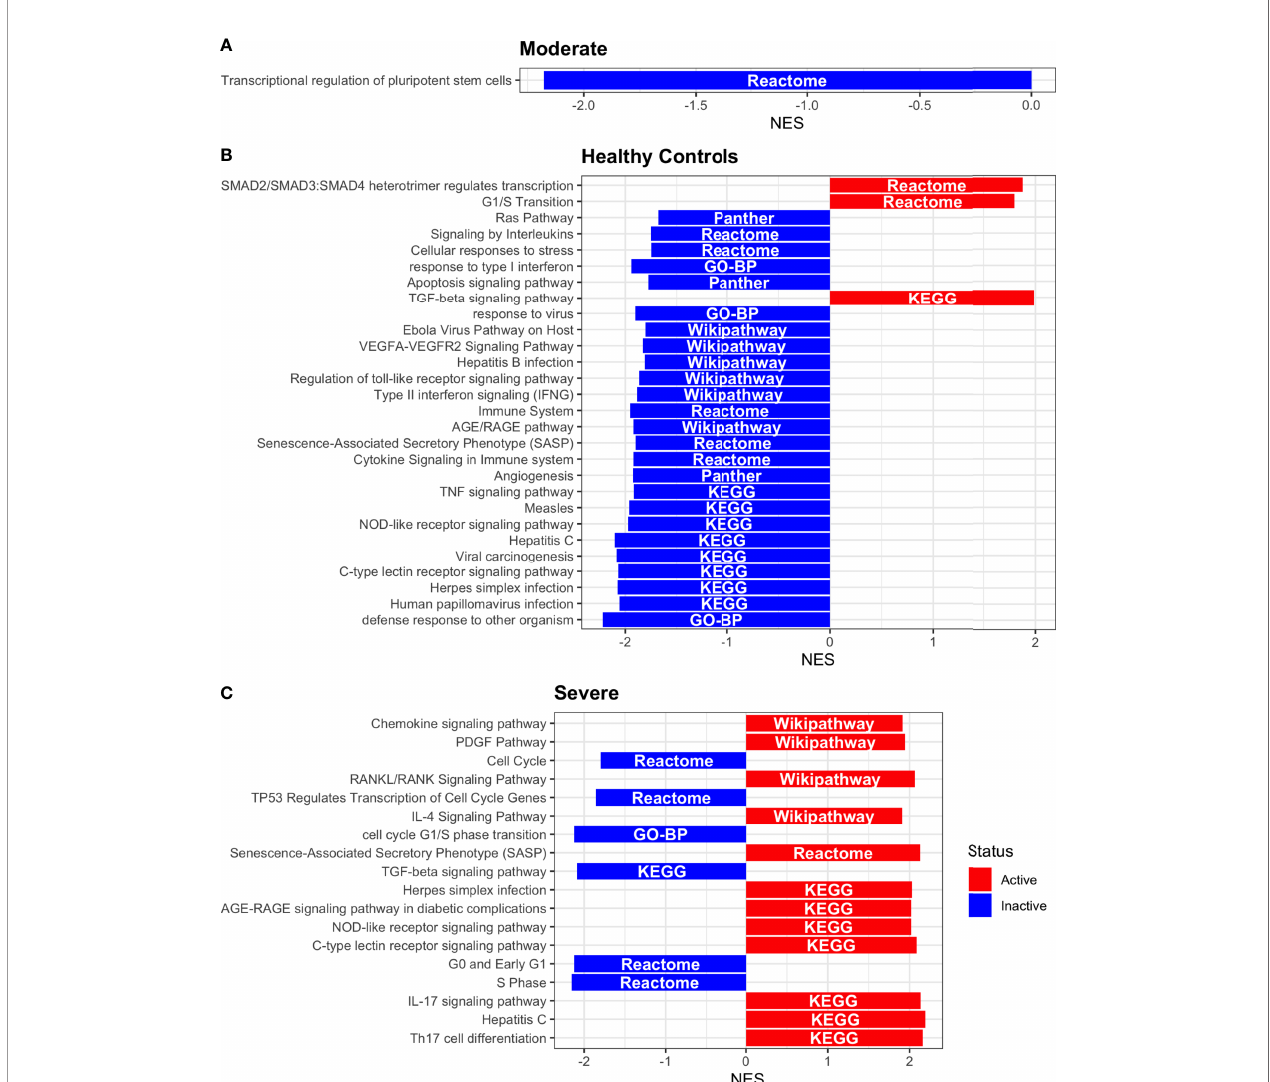
FIGURE 9 | Pathway Enrichment Analysis across various databases. Activity status of the TFs in a particular pathway found by DoROthEA across the disease severity in Dendritic Cells. (A) GSEA in moderate patients. (B) GSEA in healthy controls. (C) GSEA in severe patients. The normalized enrichment score (NES) value represents the activity status within the disease severity conditions, a positive value for active pathways (red), and a negative value for inactive pathways (blue). The dataset for every pathway (rows) is indicated inside the colored